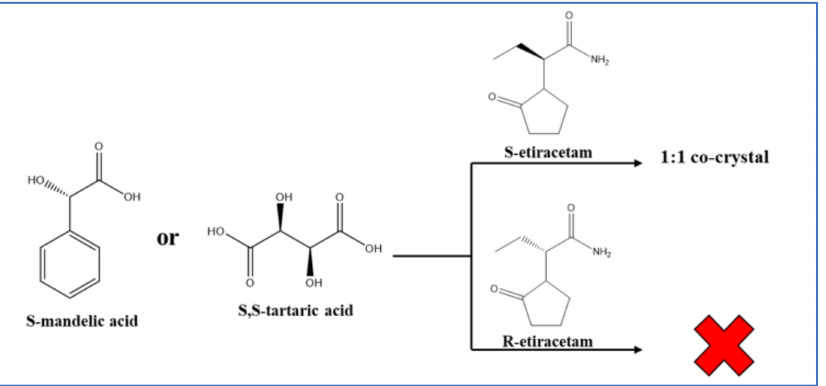
Figure 30. The enantioselective co-crystal formation in the case of S-enantiomer of 2-(2-oxopyrrodin- 1-yl)butanamide (S-etiracetam) with S-mandelic and S-tartaric acid. The same reaction with R- etiracetam does not lead to co-crystal formation